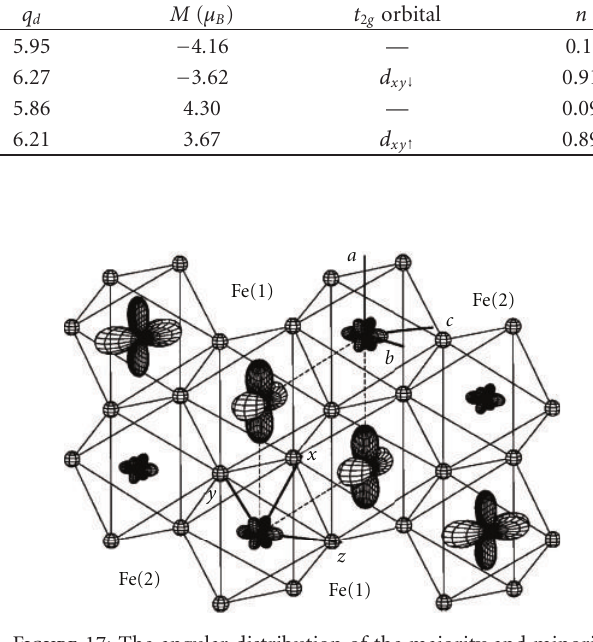
Figure 17: The angular distribution of the majority and minority spin 3 d electron density of the Fe(2) and Fe(1) cations, respectively, within Fe ribbon [211]. The size of orbital corresponds to its occu- pancy. Oxygen atoms are shown by small spheres. x - y - z coordinate system corresponds to the local cubic